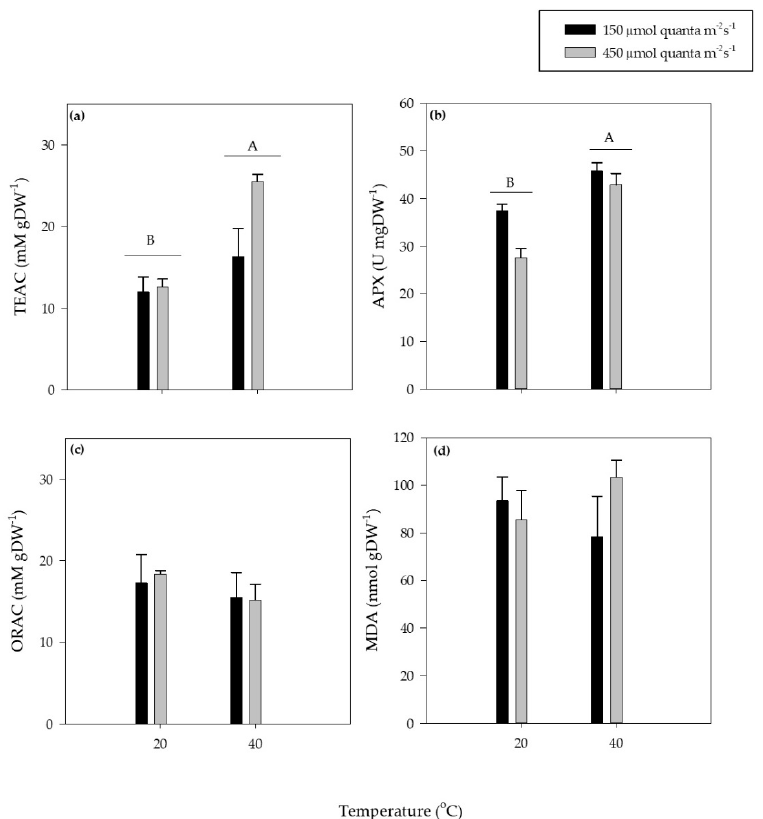
Figure 2. Effects of temperature and light on Cymodocea nodosa : ( a ) trolox equivalent antioxidant capacity (TEAC); ( b ) ascorbate peroxidase (APX) activity; ( c ) reactive oxygen species absorbance capacity (ORAC); and ( d ) malondialdehyde (MDA) concentration. Values represent mean ±SE ( n = 3). Different letters indicate significant differences among light levels under the same temperature ( p < 0.05, SNK test); * indicate significant differences among temperatures under the same light level ( p < 0.05, SNK test); capital letters indicate differences among temperature independently of light level (no interaction among factors; p < 0.05, SNK test).